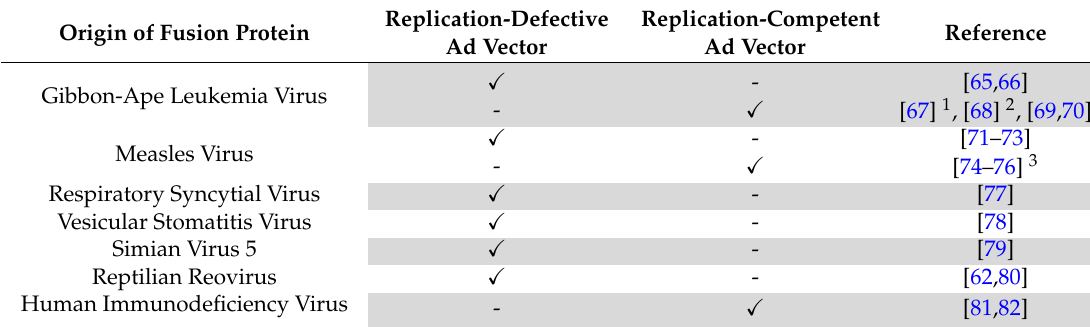
Table 1. Adenovirus expressing fusogenic